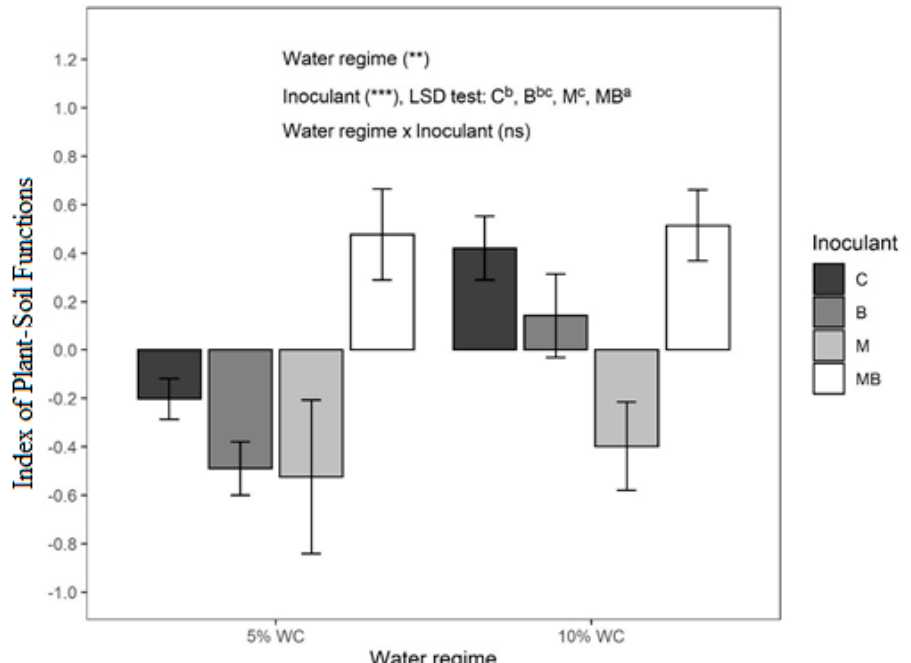
Figure 5. Mean values ( ± SE) of the index of plant-soil interactions obtained from the z-scores of nine variables in soil rhizosphere samples of L. sativa under different water regimes. In the case of significant effects (** p < 0.01, *** p < 0.001), the results of the post hoc comparisons are presented; different superscript letters denote significant differences (C = Control, B = B. subtilis , M = AMF, MB = AMF and B. subtilis